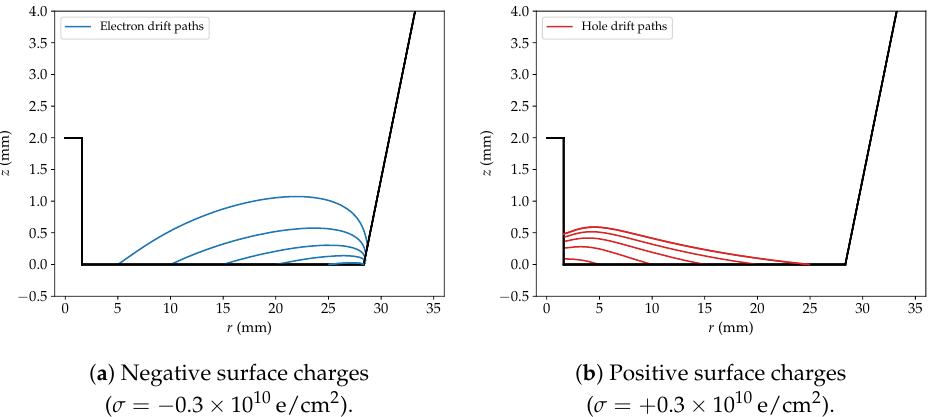
Figure 4. Simulated electron and hole drift paths for ( a ) negative and ( b ) positive charges on the passivated detector surface. The black line indicates the detector contour, the passivated surface is at z = 0. The origin of the coordinate system is at the top center of the point contact with the z -axis pointing towards the detector bulk. In the presence of negative (positive) surface charges, the holes (electrons) are attracted to the surface and stop drifting, while the electrons (holes) are repelled into the bulk and do not drift parallel to the surface but inside the bulk towards the respective contacts. The drift paths were simulated using mjd_siggen